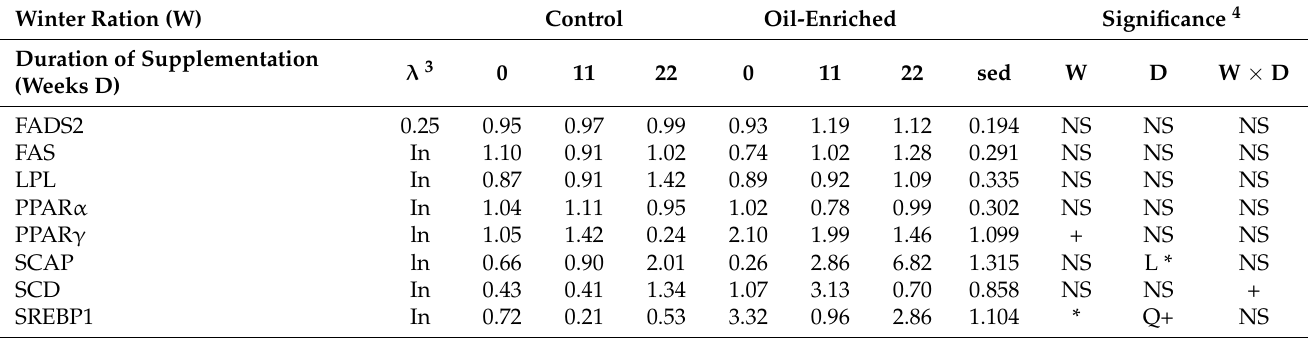
Table 7. Gene expression 1,2 in longissimus muscle of beef heifers. Control Oil-Enriched Significance